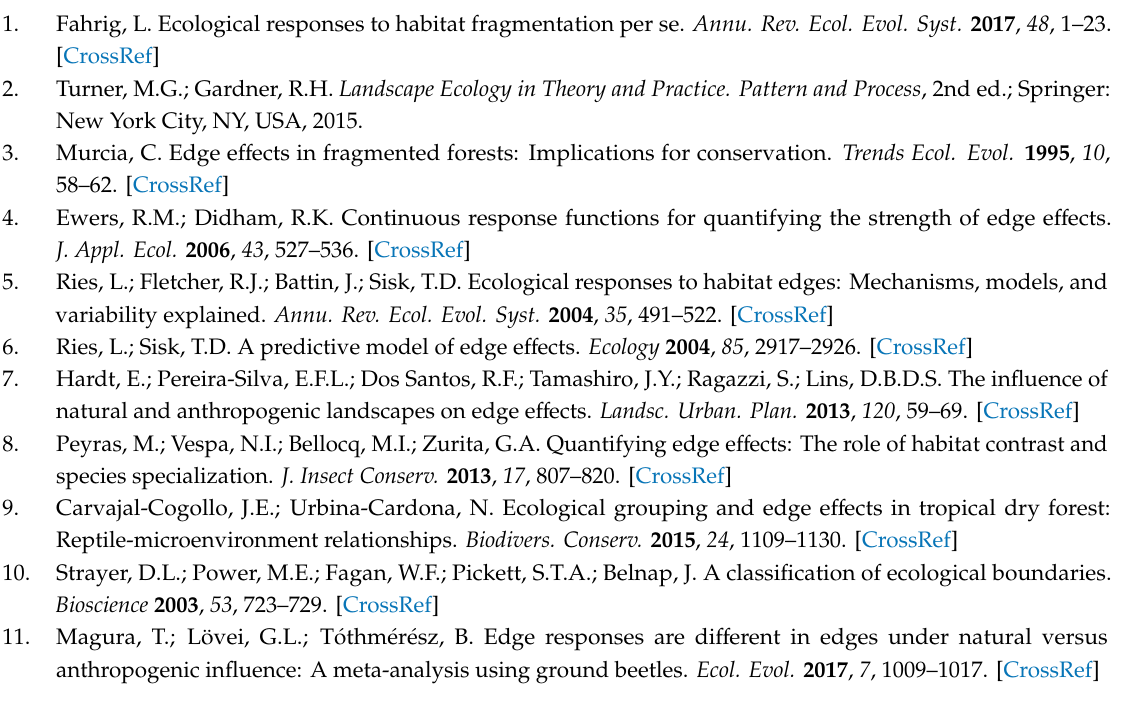
Figure S1: Funnel plots with missing data (empty circles) for the abundance of flying grasslander (macropterous open-habitat) (a) and walking specialist (brachypterous forest specialist) ground beetle species (b), Table S1: Studies used in the meta-analyses, Table S2: Ground beetle species included into the meta-analyses, their dispersal power and habitat a ffi nity, and the papers from which their abundances were extracted, Table S3: Estimates and heterogeneities in the models, Table S4: Results of regression test for funnel plot asymmetry of abundances of flying grasslander (macropterous open-habitat) and walking specialist (brachypterous forest specialist) ground beetle species, Table S5: Model results after trim and fill for the abundances of flying grasslander (macropterous open-habitat) and walking specialist (brachypterous forest specialist) ground beetle